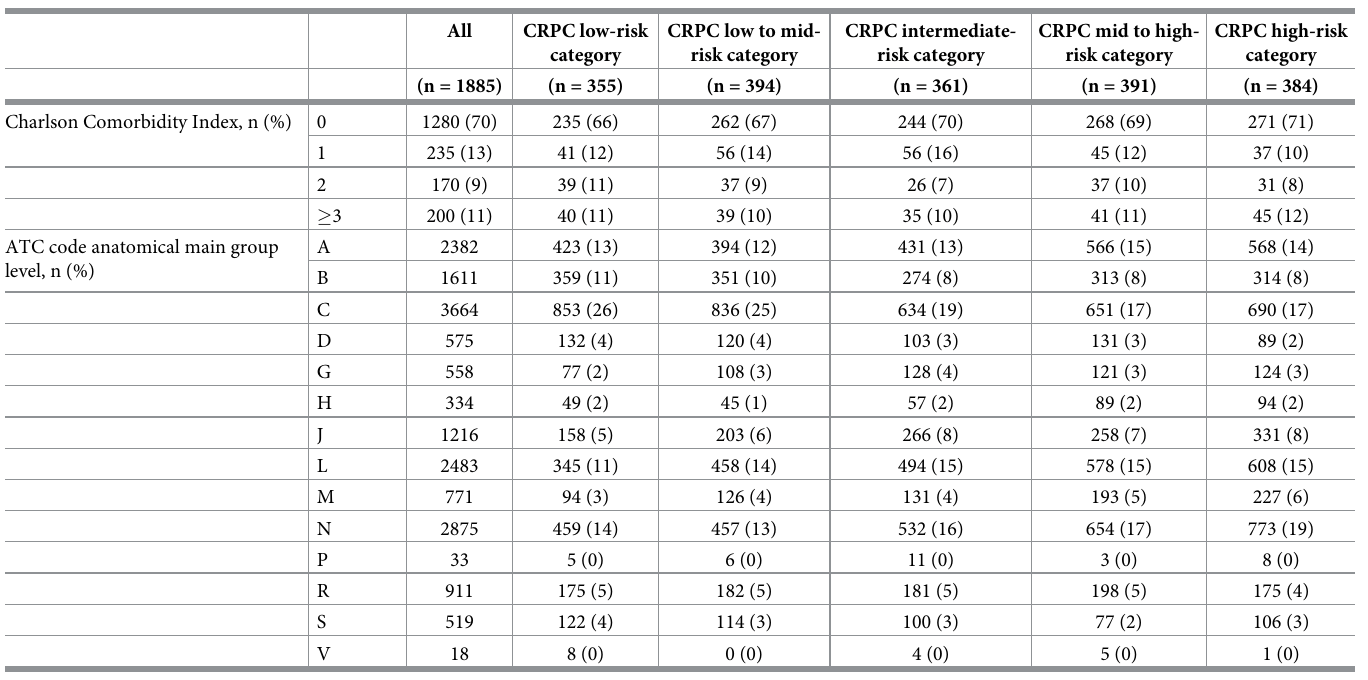
( S2 Table ). Median overall survival was 3.0 years (95% Confidence Interval [CI] 2.8–3.4) in the first tertile of DCI-CRPC and 1.0 year (95% CI 0.9–1.1) in the third tertile ( Fig 1 ). The discriminative ability of univariable model for survival with the DCI-CRPC as predic- tor (C-index 0.667) was slightly higher compared to the original DCI (C-index 0.633), and sub- stantially higher than for the CCI (C-index 0.508). When the discriminative ability of the